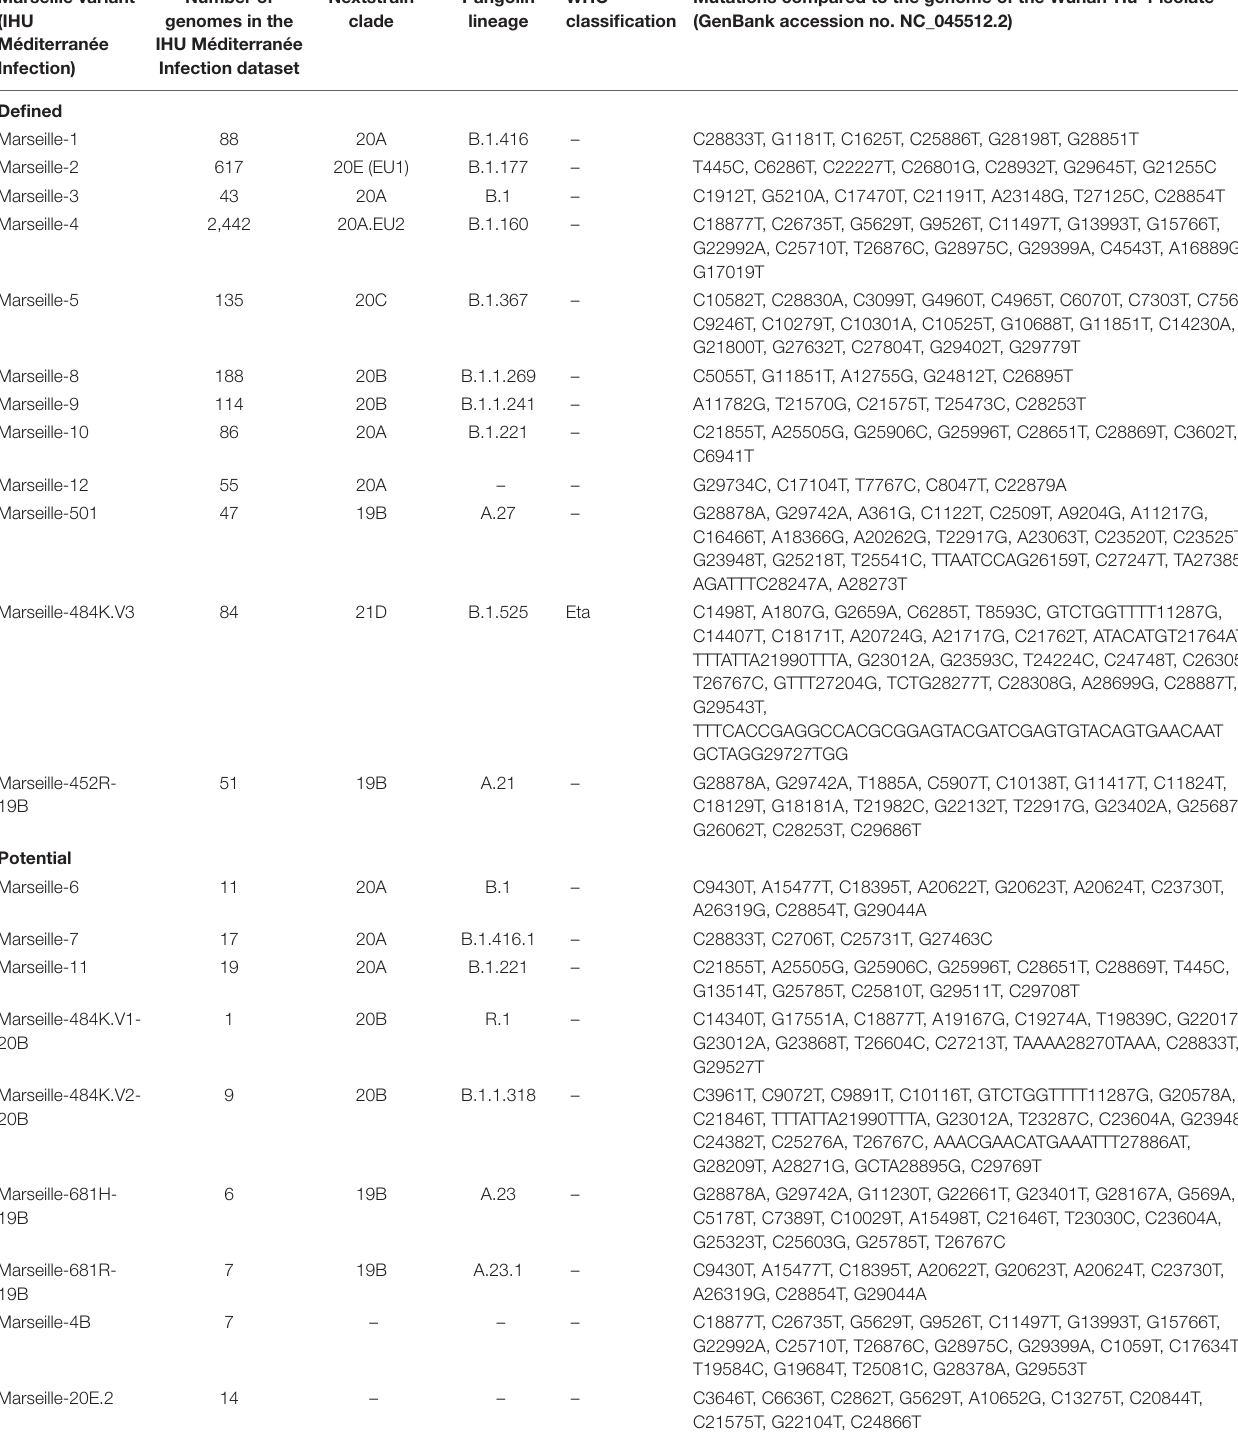
TABLE 1 | Nomenclature and description of Marseille (IHU Méditerranée Infection) variants of